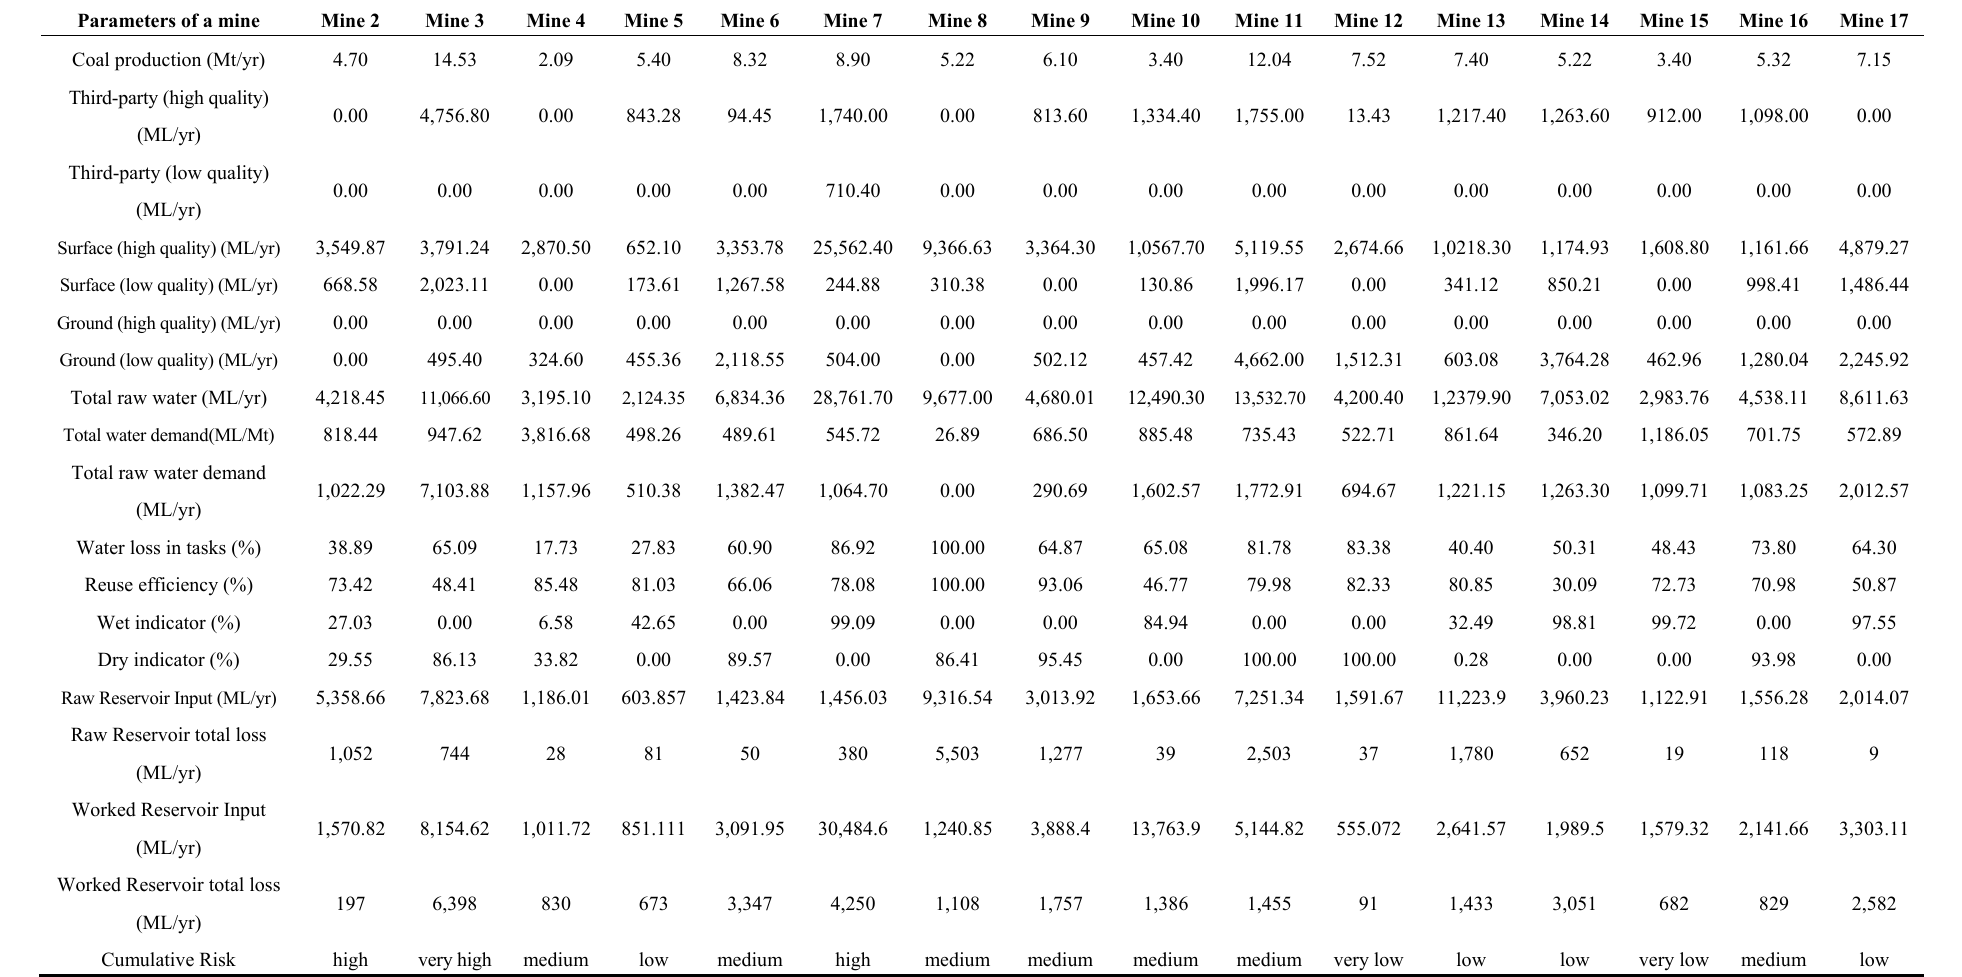
Table A5. Data sources of the 16 mines (some original data and derived data being